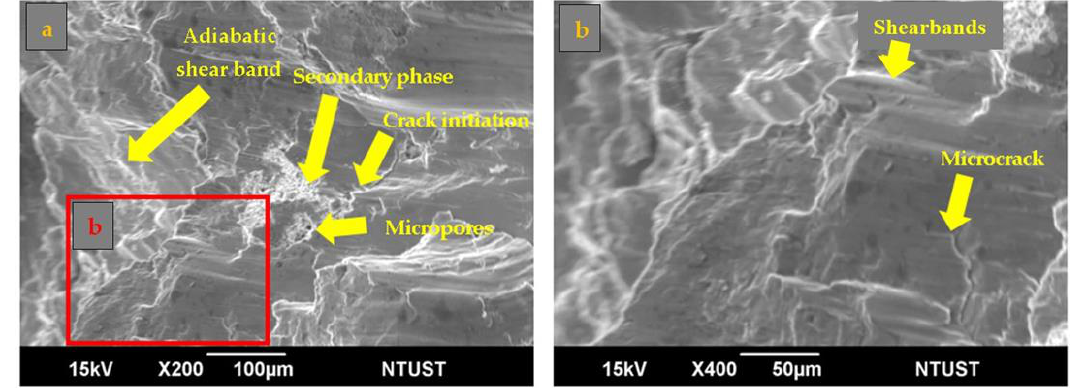
Figure 12. ( a ) The fracture surface morphology of 6% Nb 2 O 5 + AZ31. ( b ) Magnified inset fracture surface of figure ( a ).